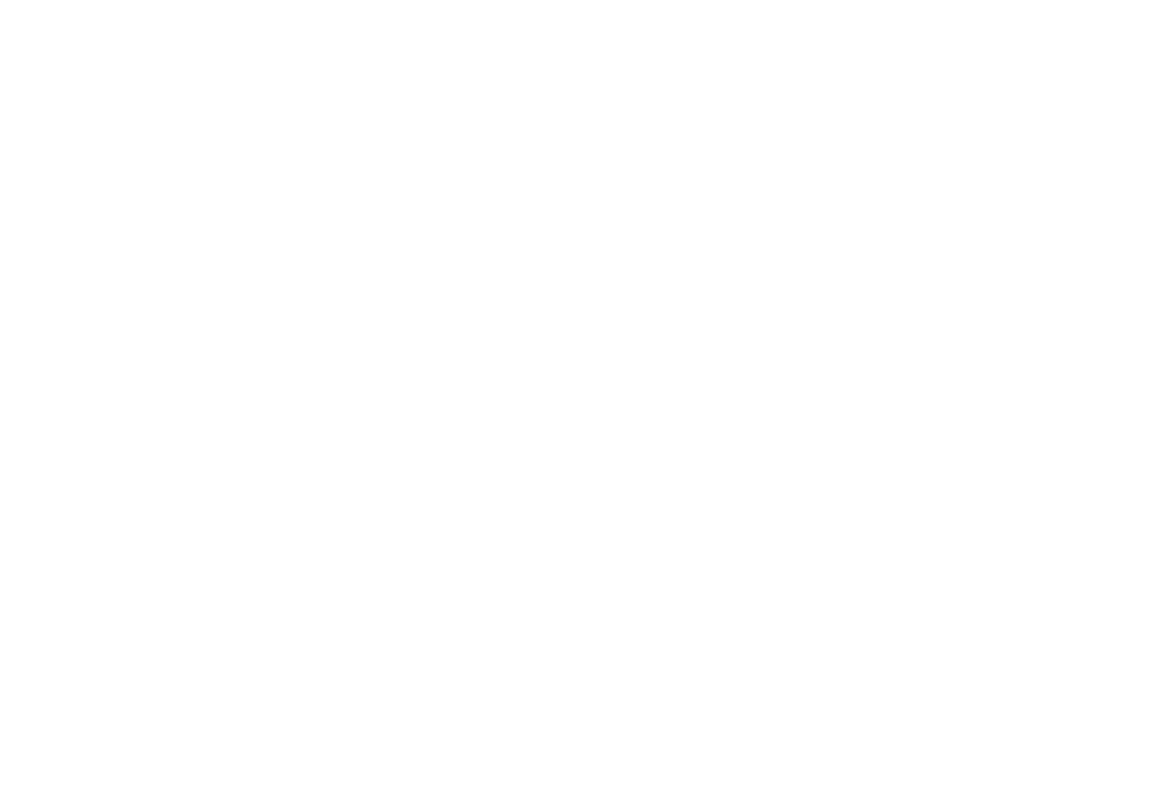
Frontiers in Robotics and AI | www.frontiersin.org